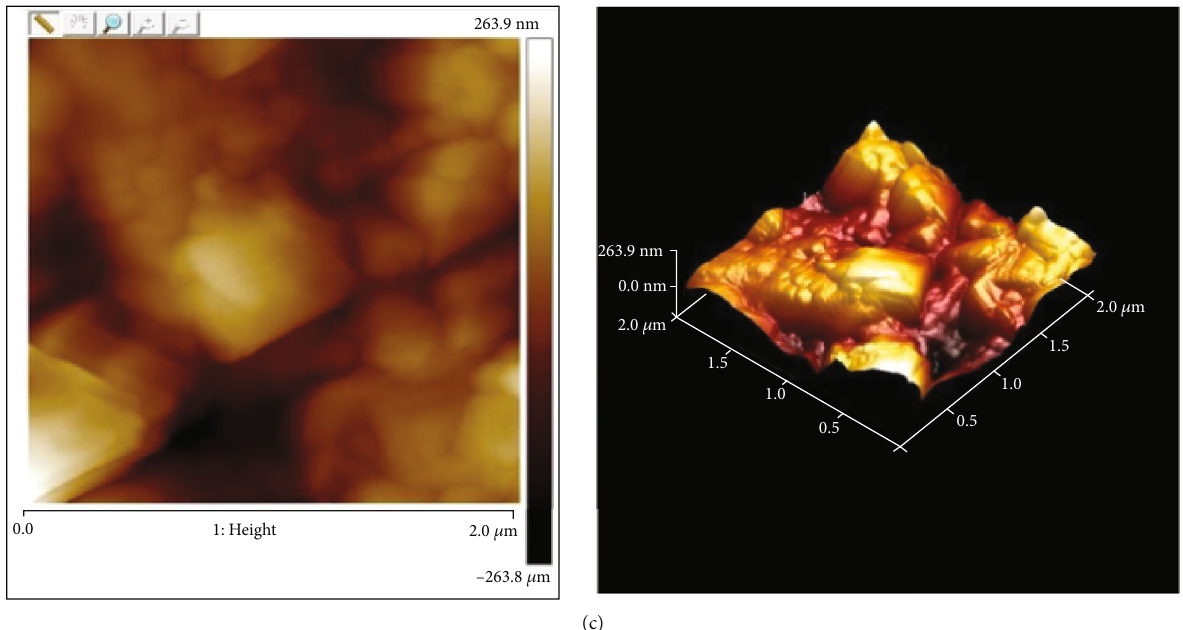
Figure 3: AFM images of composite membranes prepared with di ff erent MG concentrations: (a) 0 wt%, (b) 0.004wt%, and (c)